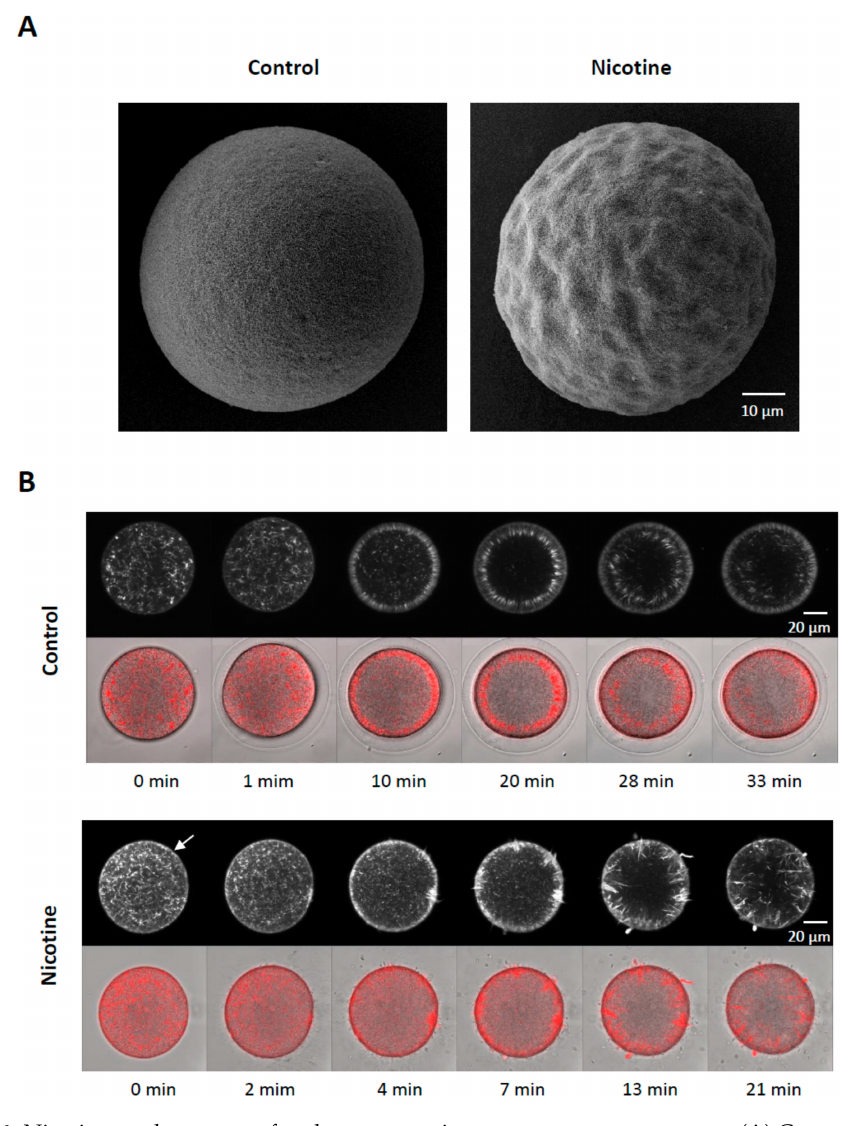
Figure 6. Nicotine renders egg surface hyper-receptive to supernumerary sperm. ( A ) Comparison of the cell surface topography of the jelly free eggs by scanning electron microscopy after pretreatment of the eggs in the presence or absence of 5 mM nicotine (5 min). ( B ) E ff ects of nicotine on the mobilization of cortical actin filaments following fertilization. P. lividus eggs were microinjected with AlexaFluor568-Phalloidin and subsequently incubated in the presence or absence of 20 mM nicotine for 5 min. The eggs were then fertilized in fresh NSW and the distribution of actin filaments were continuously monitored by confocal microscopy. Merged images with the bright field view show lack of fertilization envelope elevation in nicotine-pretreated eggs. The post-fertilization time points were shown below the merged view of the same egg at the given moment. The images labeled 0 min refer to the ones captured immediately before the addition of